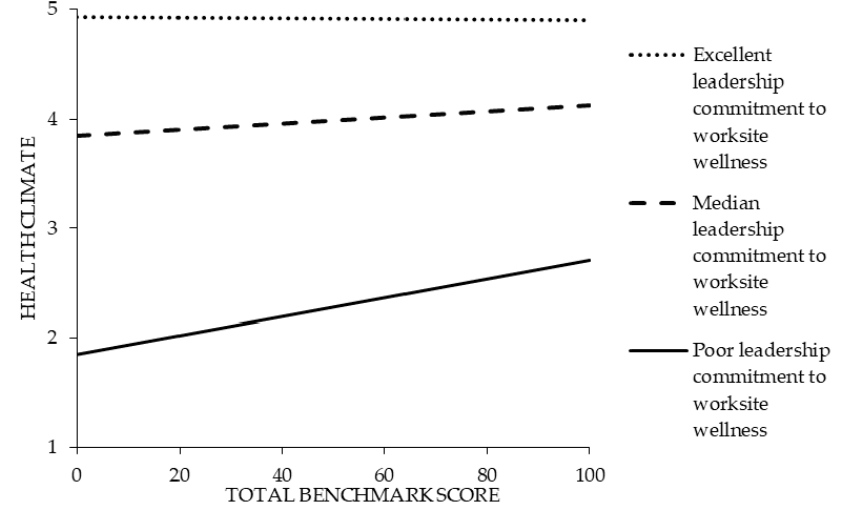
Figure 3. The interactive relationship between total benchmark score and leadership commitment to worksite wellness on health climate.